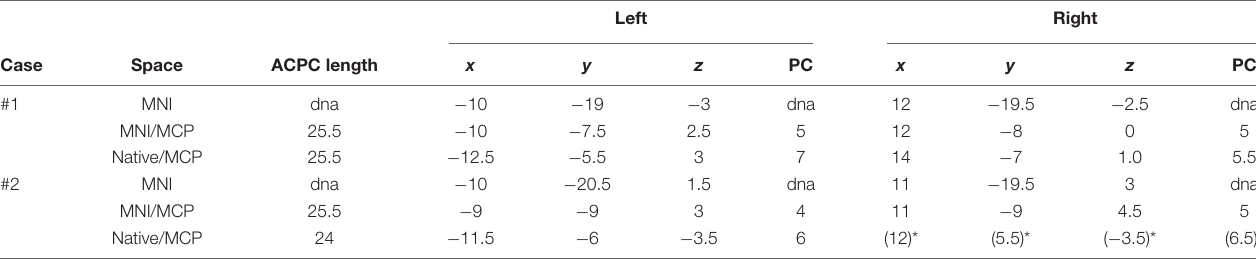
TABLE 1 | Coordinates of effective contacts during chronic stimulation.